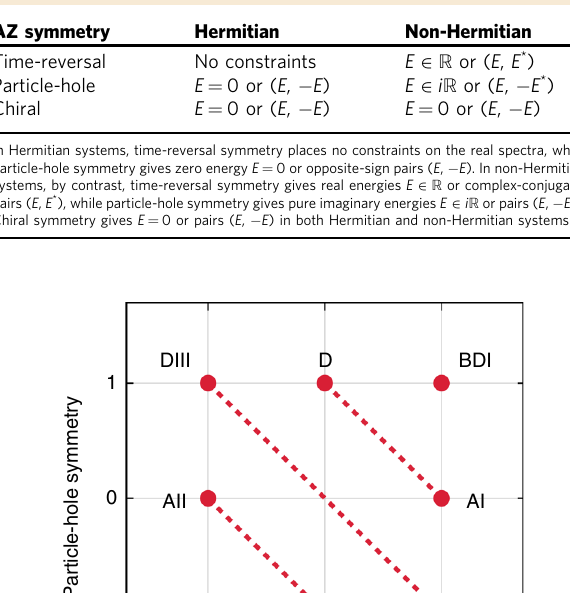
Table 1 Constraints on the complex spectra imposed by